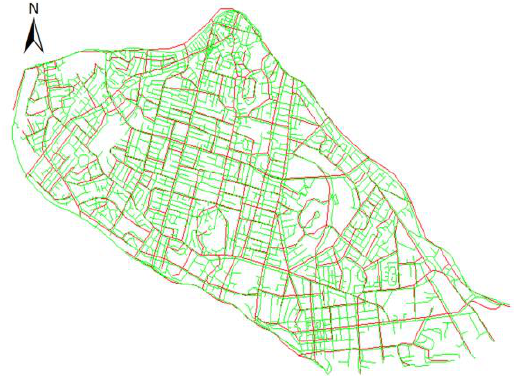
ff erent-scale road network pairs from Wuhan City (Area 2). ISPRS Int. J. Geo-Inf. 2020 , 7 , x FOR PEER REVIEW Figure 14. Different-scale road network pairs from Wuhan City (Area 2). Figure 14. Di Figure 14. Different-scale road network pairs from Wuhan City (Area 2).